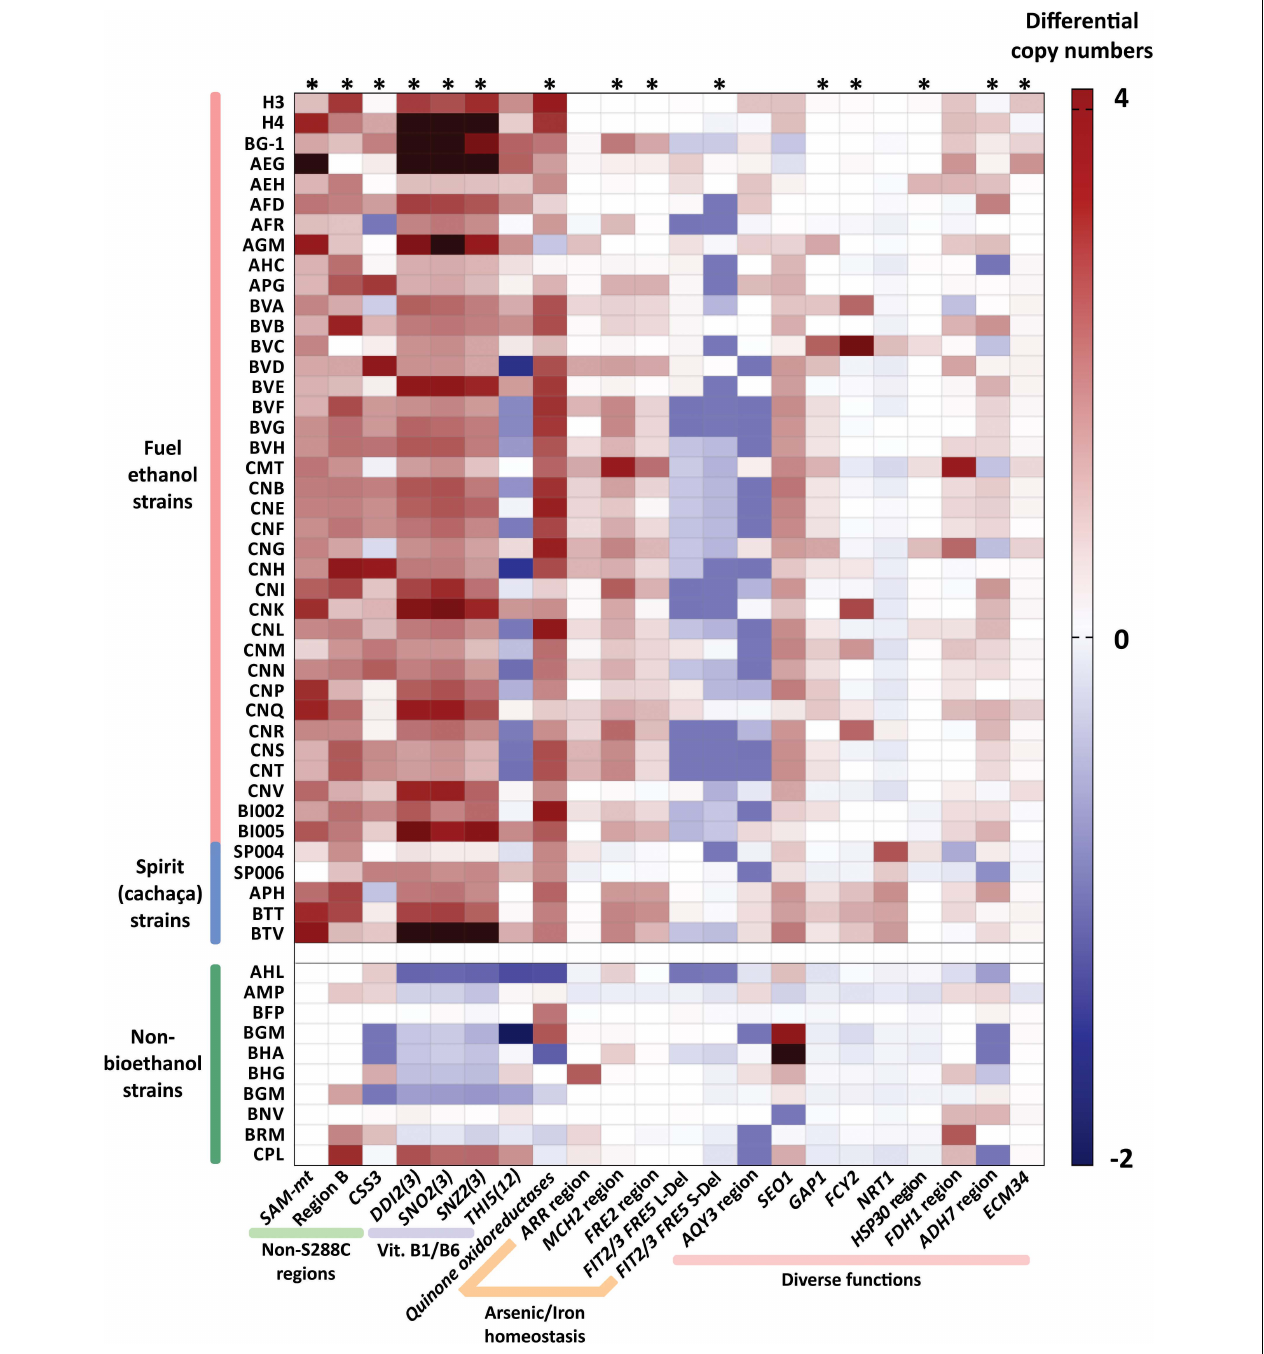
FIGURE 4 | Differential copy numbers of genes/regions in strains of the bioethanol group compared to S288C. Copy numbers of key genes/regions (labeled at the bottom) were measured in bioethanol yeasts by read depth based on Illumina sequence data. The estimated CNVs of probed genes/regions were discounted from the expected copy numbers according to the S288C genome annotation. A heatmap is shown depicting a color scheme in which extra copies in strains of the bioethanol group are quantitatively expressed in a red gradient (up to four copies). Equal number of copies found in both bioethanol and S288C strains is represented in white, while surplus of copy numbers in S288C is displayed as a blue gradient. Note that in some cases, hemizygous patterns account for non-integer gene copy numbers, since multiple diploid genomes are represented within the dataset (Peter et al., 2018). A group of ten randomly chosen non-bioethanol yeasts were included as external controls. Dark red colored boxes outside the red gradient range represent cases in which more than four extra copies of the probed gene/region were counted. Significant enrichment of CNV among the bioethanol clade is indicated with an asterisk ( ∗ ) above the respective column ( p < 0.05, Mann-Whitney U